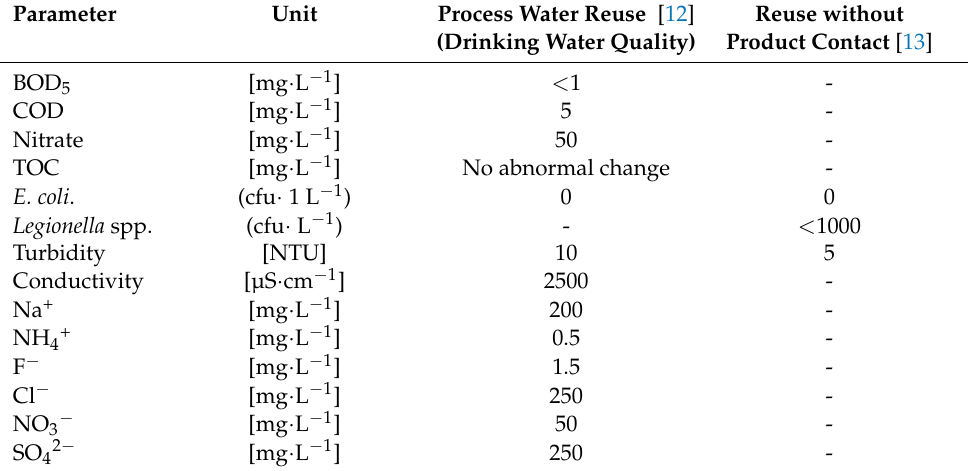
Table 1. Limits for wastewater